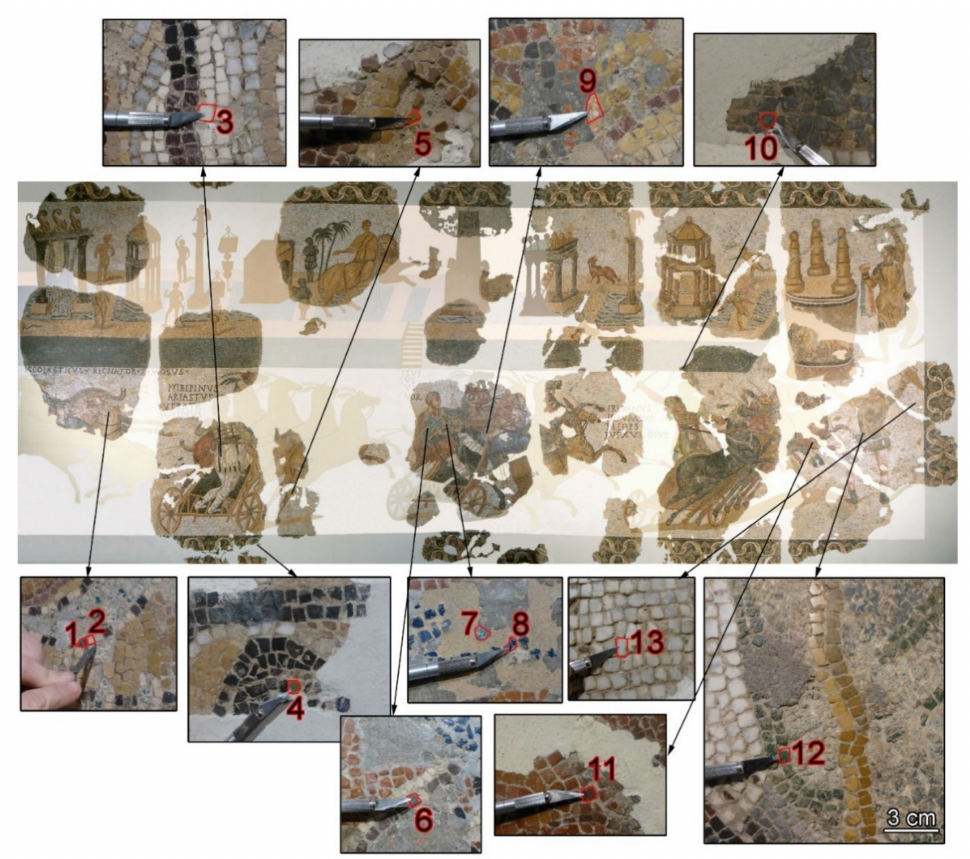
Figure 1. In the center, a general view of the Circus mosaic, and the smaller surrounding images illustrate the zoomed parts to identify the numbered tesserae in their original locations before their